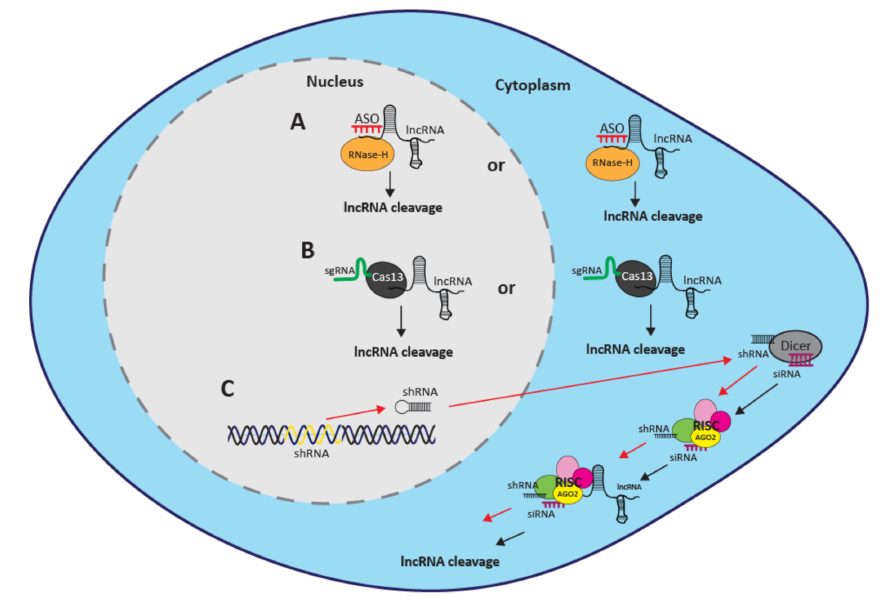
Figure 2. Methods for direct targeting. ( A ) Binding of the ASO to the lncRNA transcript leads to RNase-H mediated degradation resulting in post-transcriptional knockdown, which can occur in either the nucleus or the cytoplasm. ( B ) A sgRNA guides Cas13 to the lncRNA transcript resulting in post-transcriptional knockdown, which can occur in either the nucleus or the cytoplasm. ( C ) Red arrows depict shRNA mediated RNAi in which shRNAs are integrated into the genomic DNA prior to transport to the cytoplasm. Black arrows depict siRNA mediated RNAi in the cytoplasm. RNase Dicer cleaves double stranded RNA to generate single-stranded RNAs. The single-stranded RNAs form a complex with RISC and the lncRNA, resulting in degradation of the transcript by